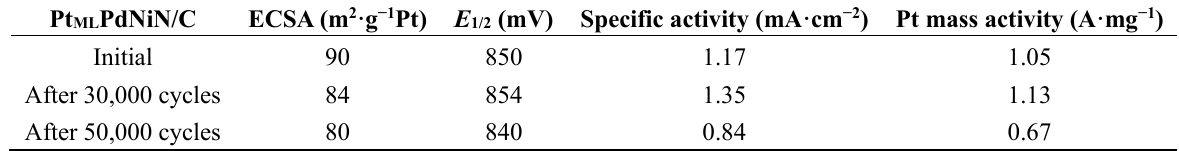
Table 1. Catalytic activities of the Pt ML PdNiN/C catalyst before and after the accelerated durability